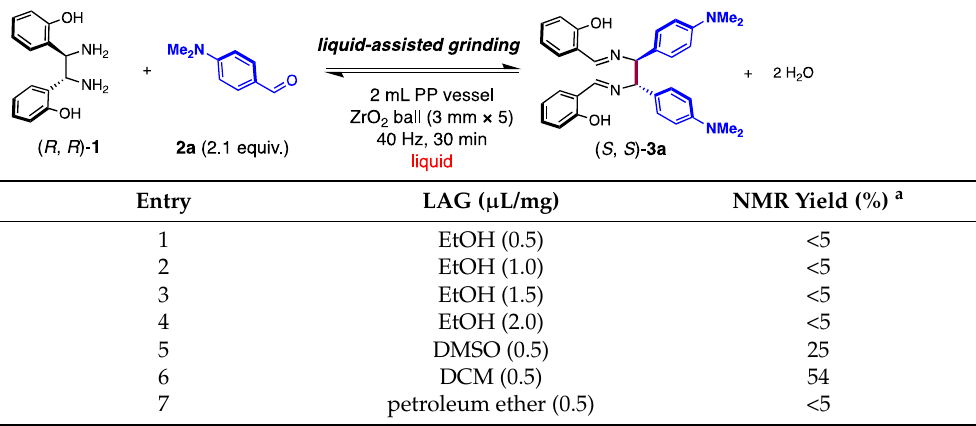
Table 3. Solvent effect in mechanochemical liquid-assisted grinding-induced DCR reaction between mother diamine ( R , R )- 1 and 2a .